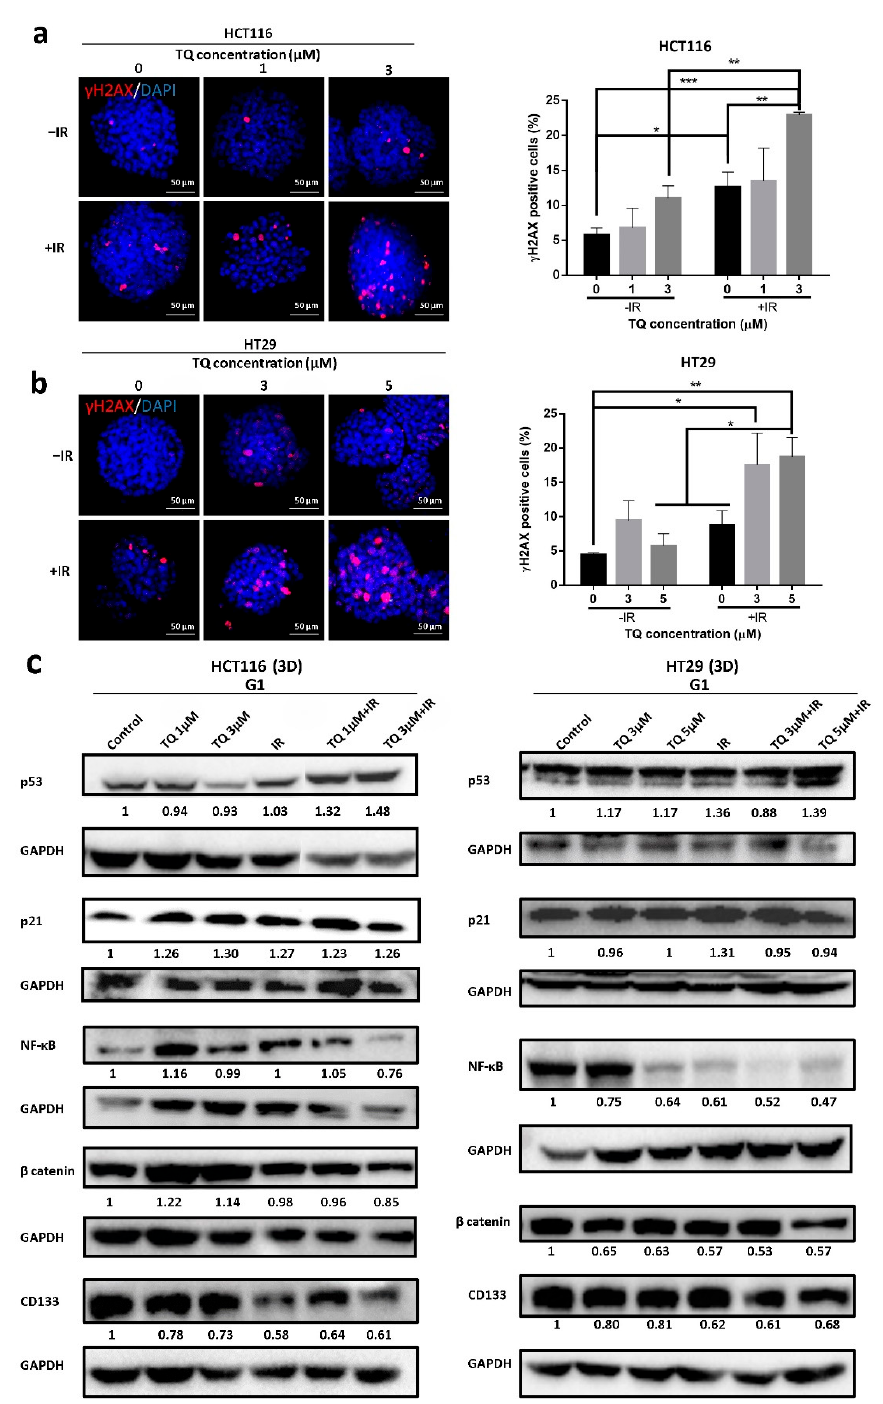
Figure 5. TQ radiosensitization of CRC stem/progenitor cells leads to inhibition of DNA repair and stemness. Representative images of TQ, IR, and combinations treated HCT116 ( a ) and HT29 ( b ) G1 spheres after γ H2AX staining. γ H2AX positive cells were counted and normalized to size. Data represent an average of three independent experiments and are reported as mean ± SEM (* p < 0.05; ** p < 0.01; *** p < 0.001). Scale bar 50 µm. ( c ) Analysis of p53, p21, NF- κ B (p65), β catenin, and CD133 protein expression in HCT116 and HT29 G1 spheres following treatment with TQ, IR, and combinations. Fold expression changes normalized to GAPDH.